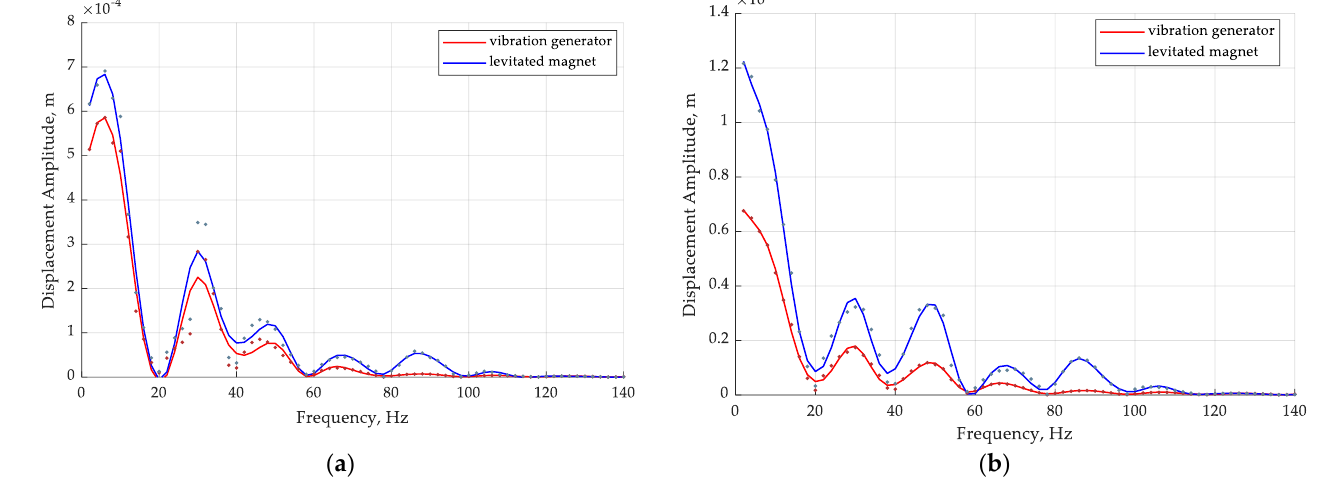
Figure 10. The amplitude frequency characteristics of the vibration generator and levitated magnet movement for the amplitude of input current ( a ) 0.35 A and ( b ) 0.75 A.